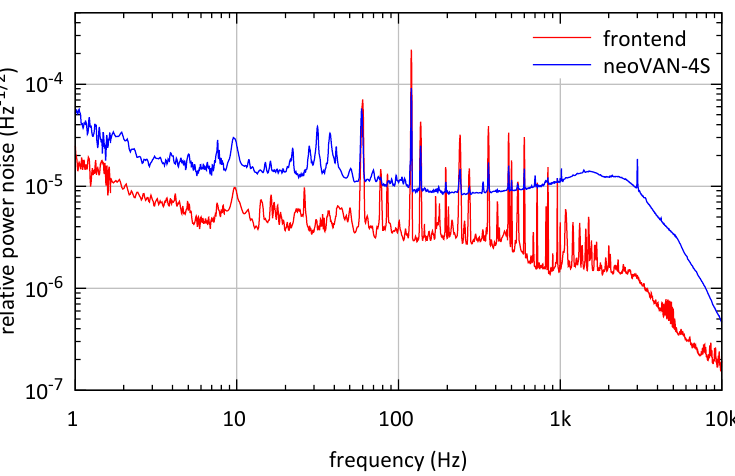
Figure 3. Relative power noise (RPN) measurements of the front-end laser beam and the laser beam amplified by the neoVAN-4S amplifier. The RPN is increased by the neoVAN-4S amplifier’s amplification. Measurements at the AEI Hannover showed that this is due to noise added by the pump diode power supplies.